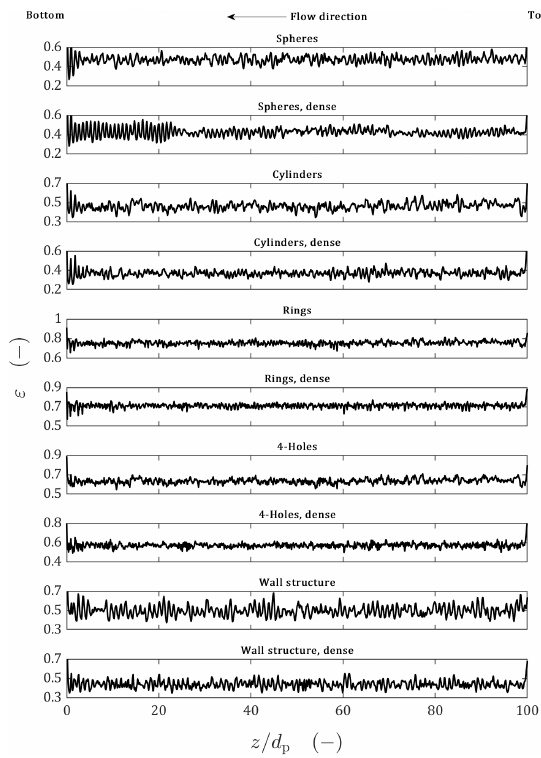
Figure 6. Axial void fraction profiles for all investigated